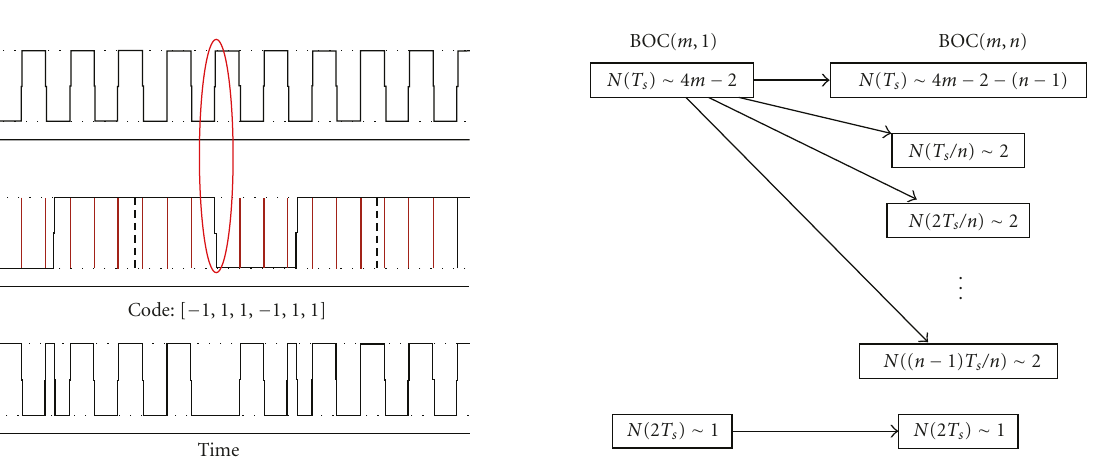
Figure 3: Starting with the steady distribution for BOC( m ,1) (left); the distribution for BOC( m , n ) (right) is obtained by splitting T s run lengths.